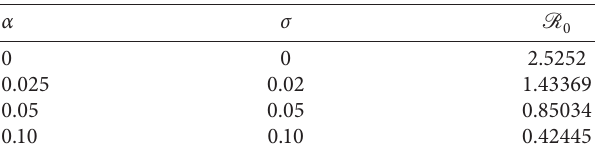
Table 5: Morally corrupt-basic reproduction number R different values of α and σ